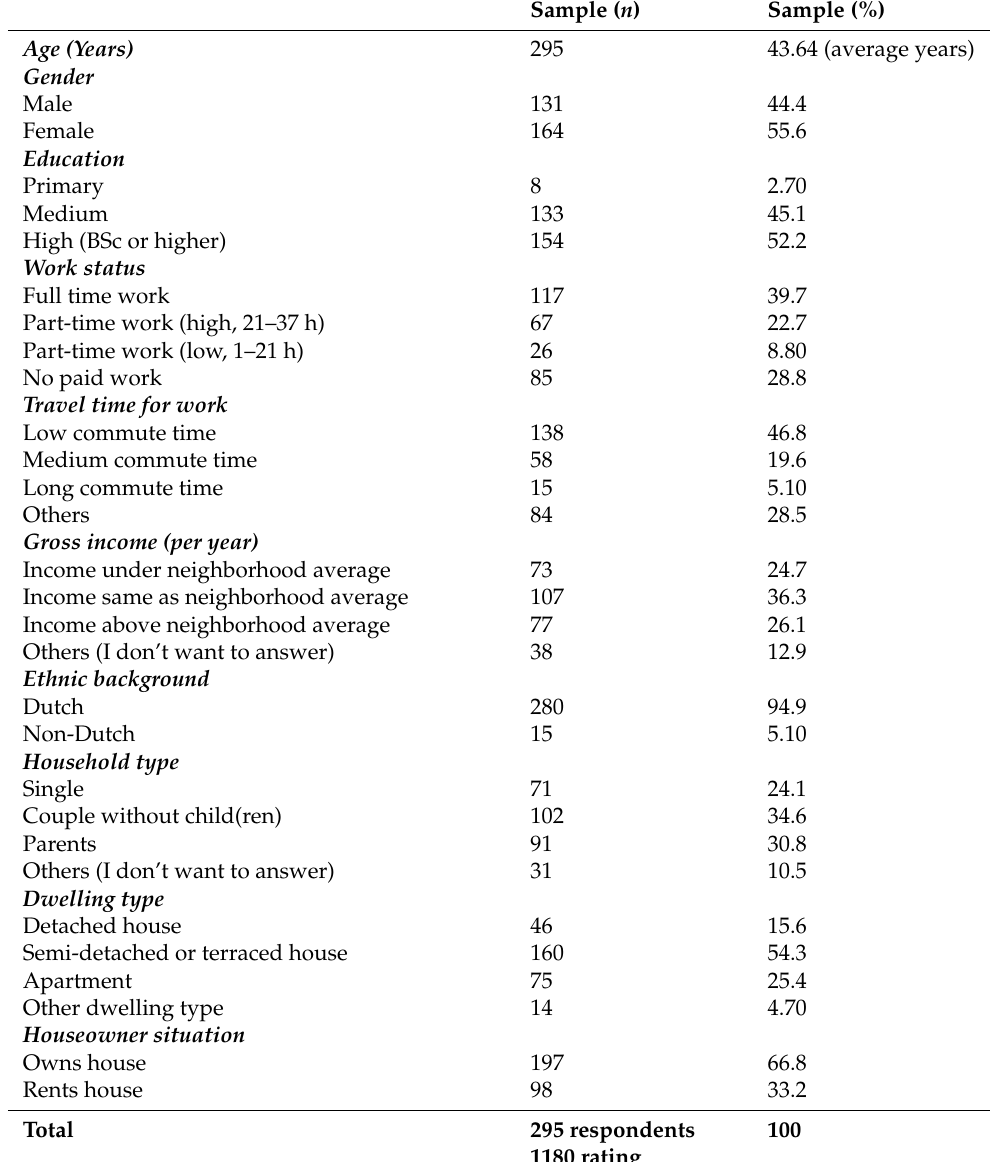
Table 2. The sample